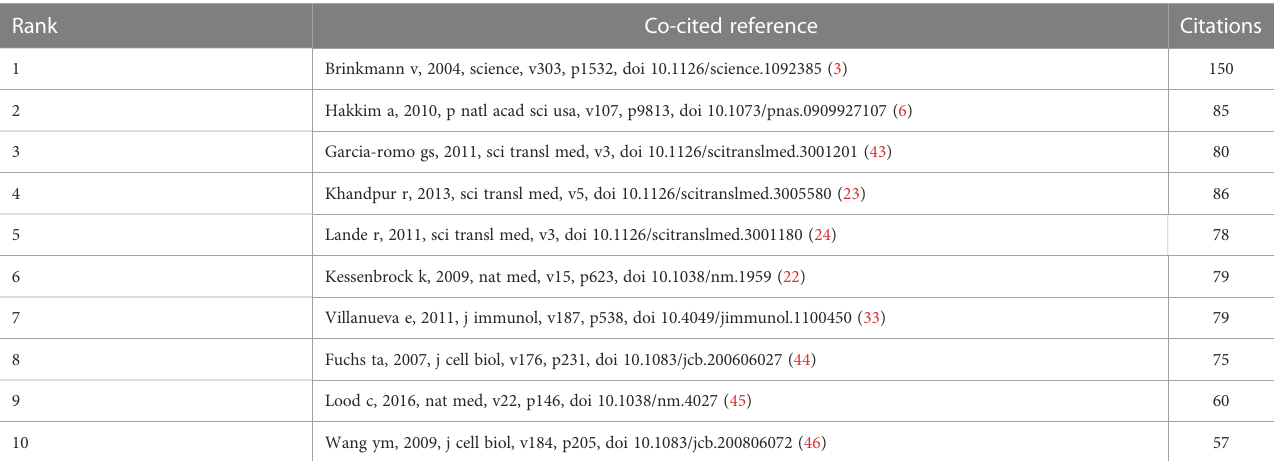
TABLE 4 Top 10 co-cited references on the research of NETs in AIDs.